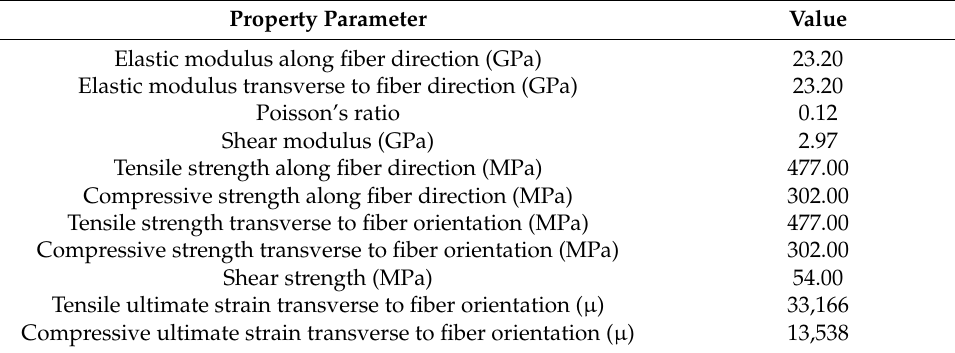
Table 1. Mechanical properties of the woven glass fiber reinforced polymer